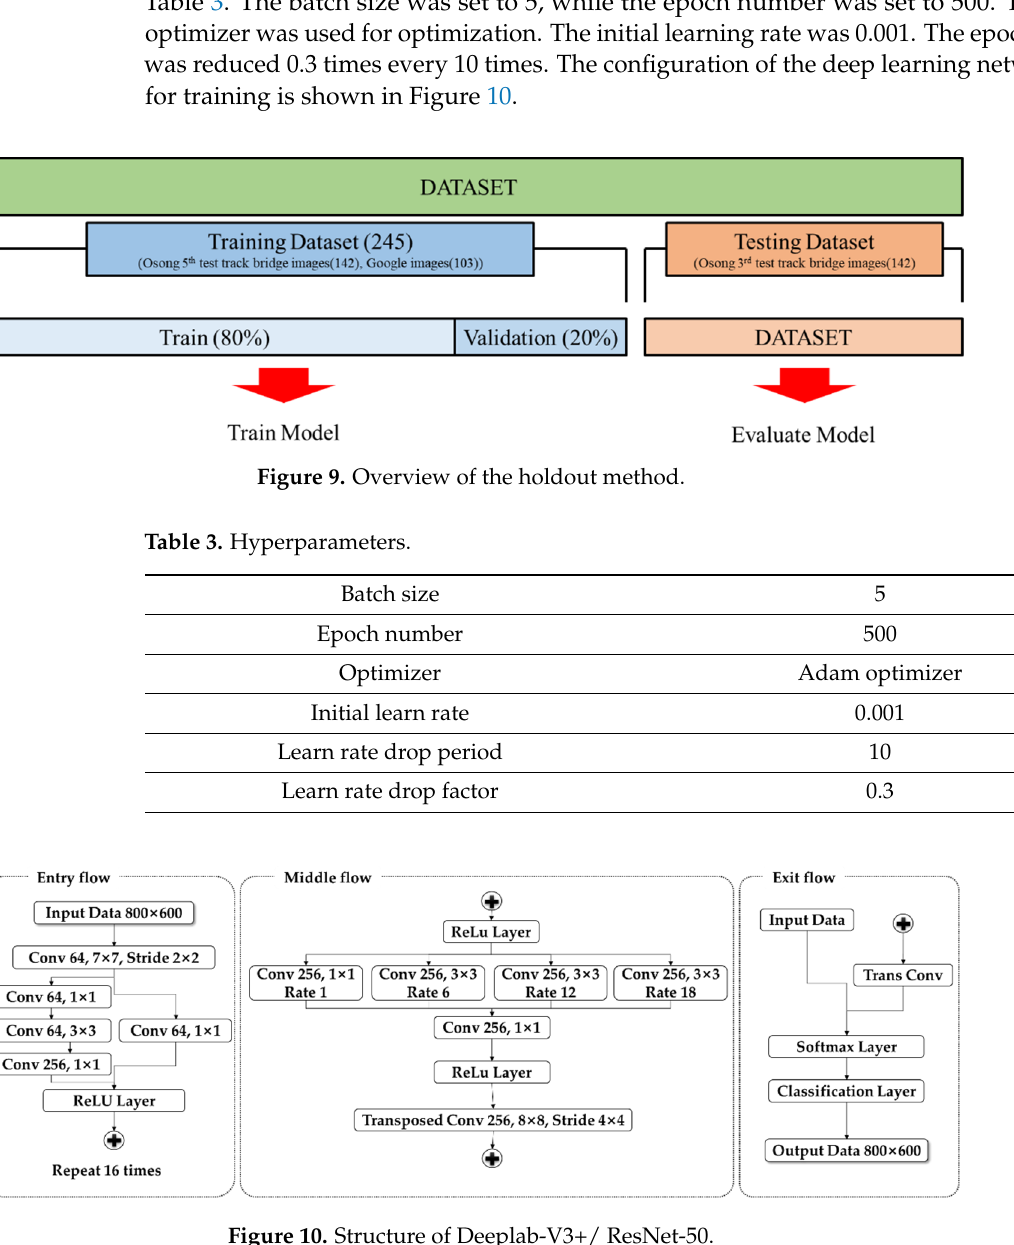
Figure 8. Osong 5th test track bridge images and labels.